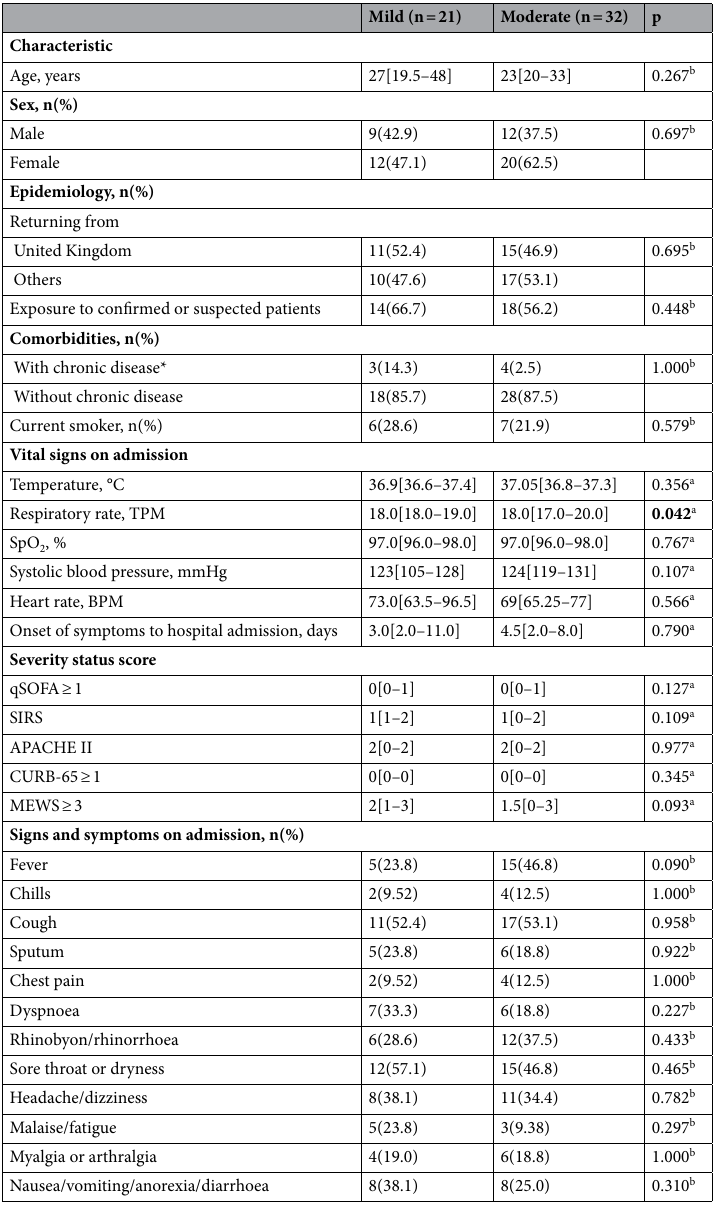
Table 1. Clinical characteristics of the participants with COVID-19. SpO 2 pulse oximeter O 2 saturation; qSOFA quick sequential organ failure assessment; SIRS systemic inflammatory response syndrome; APACHE II acute physiology and chronic health evaluation II; MEWS modified early warning score; TPM times per minute; BPM beats per minute. *Chronic diseases refer to chronic obstructive pulmonary disease, asthma, bronchiectasis, interstitial lung disease, hypertension, diabetes, and intrapulmonary or extrapulmonary malignancy. a p according to the Wilcoxon rank sum test. b p according to the χ 2 test. All bold values indicate significant differences at the level of 0.05 for a highlight